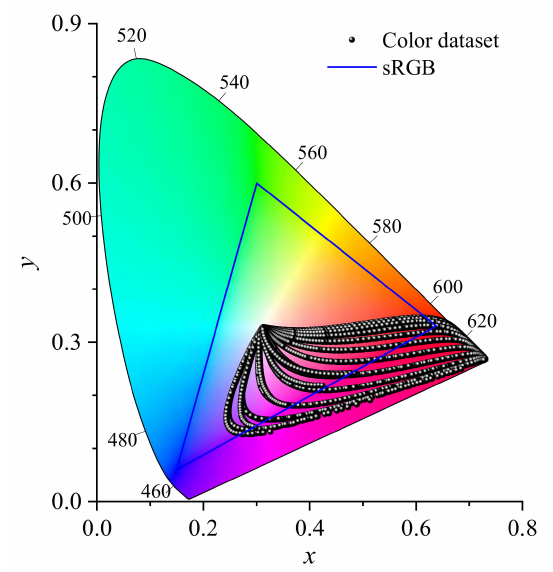
Figure 2. The 12,000 colors generated by gold nanoparticle systems plotted in a CIE 1931-XYZ chromaticity diagram. The boundary of the sRGB color space is marked with blue